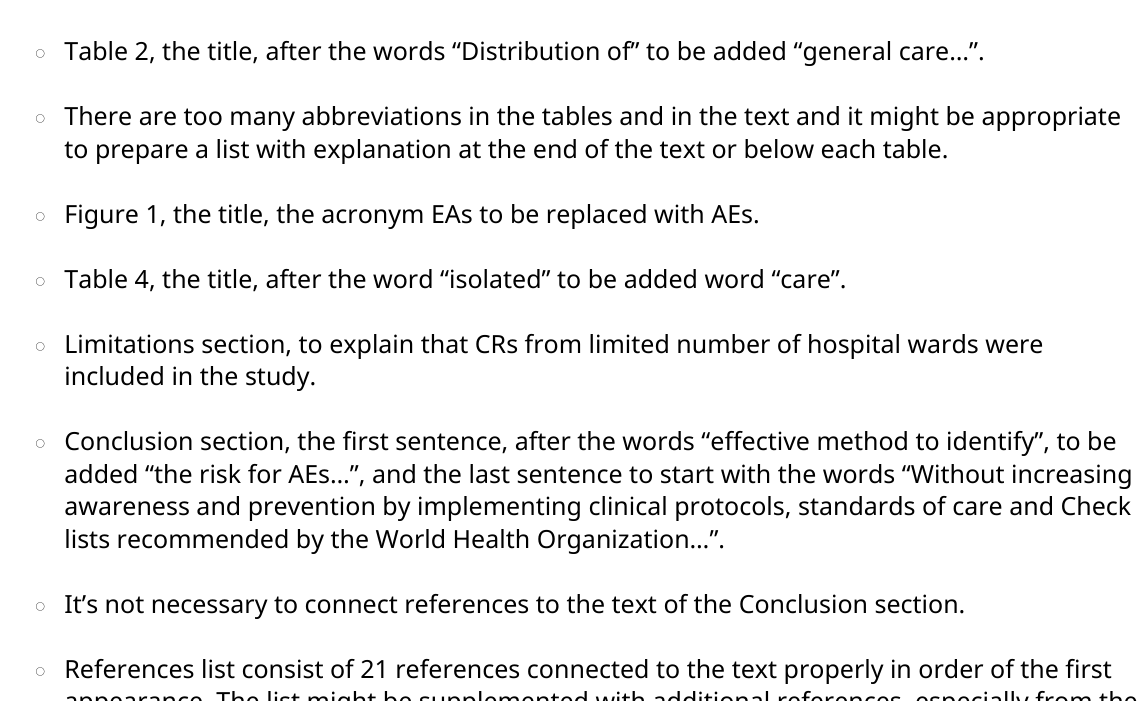
Table 2, the title, after the words “Distribution of” to be added “general care…”. ○